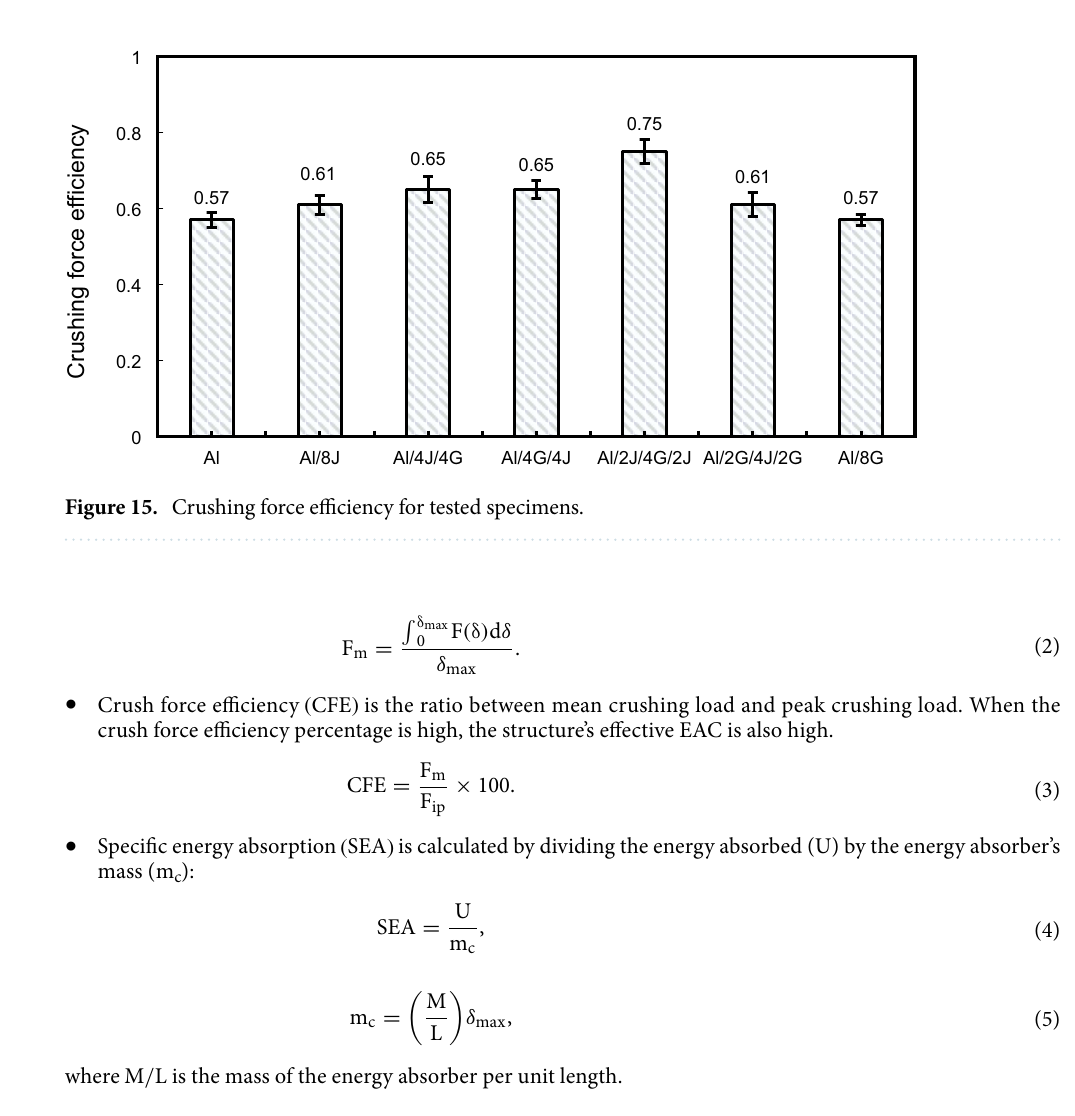
Figure 14. Specific energy absorption for tested specimens.